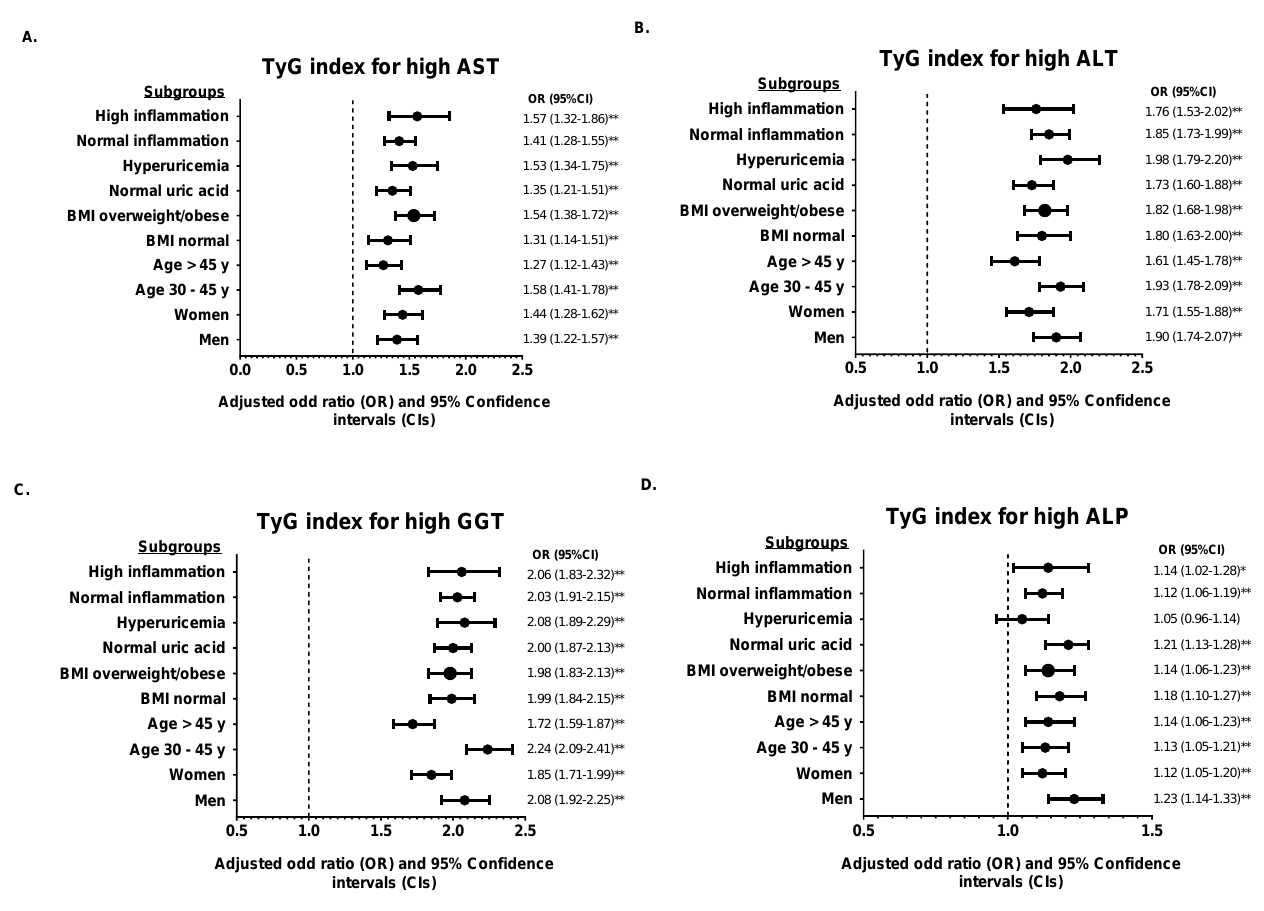
Figure 2. Subgroup analysis of the association between TyG index in quintile 5 (Q4) with ( A ) high AST, ( B ) high ALT, ( C ) high GGT, and ( D ) high ALP. Quintile 3 (Q3) was used for the reference. The odds ratio (OR) was adjusted with model 2 except for stratified variables in each subgroup. * p < 0.05, ** p < 0.01 for comparison of Q5 to Q3.